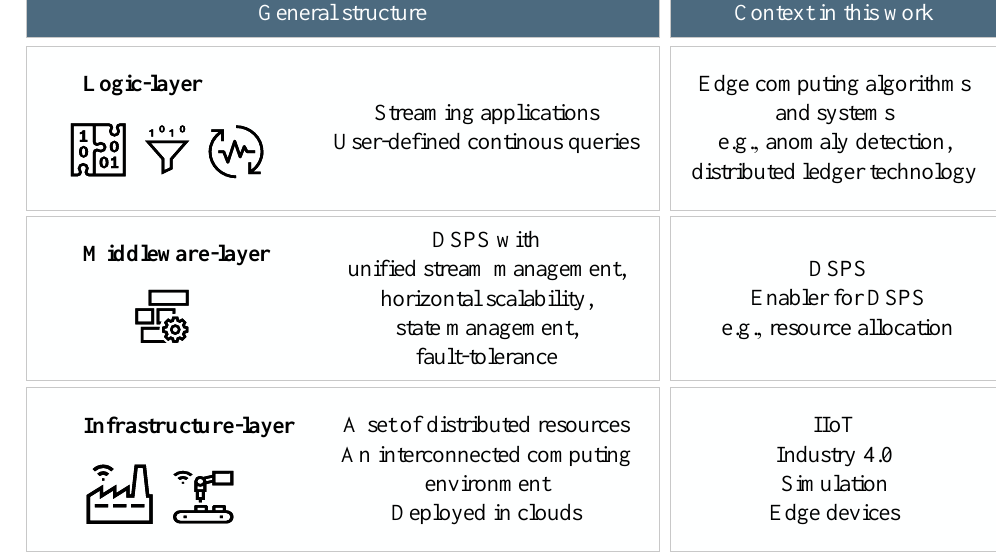
Figure 4. Three-layer architecture of a data stream system (according to [10]) in the context of this